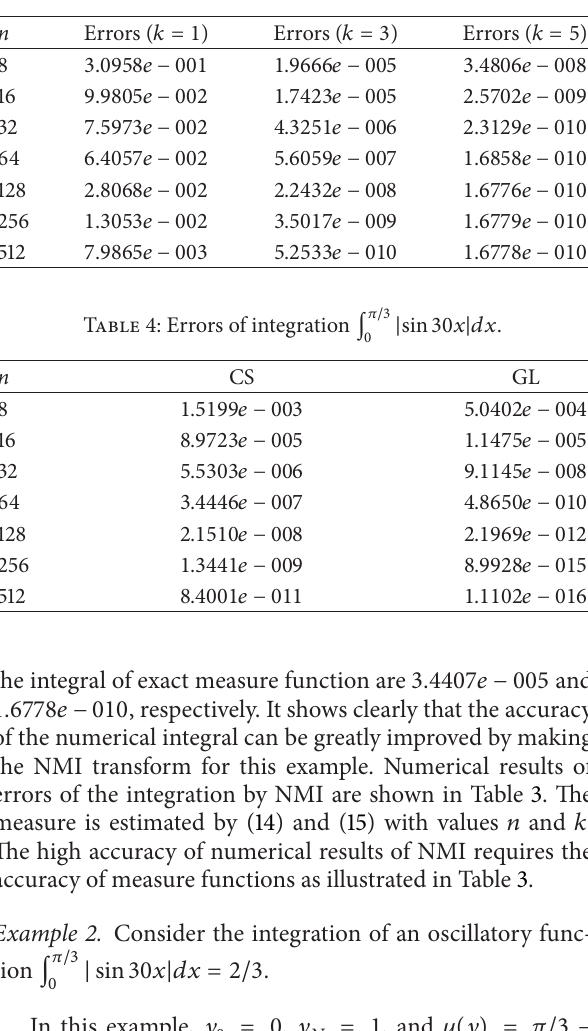
Table 5: Errors of integration ∫